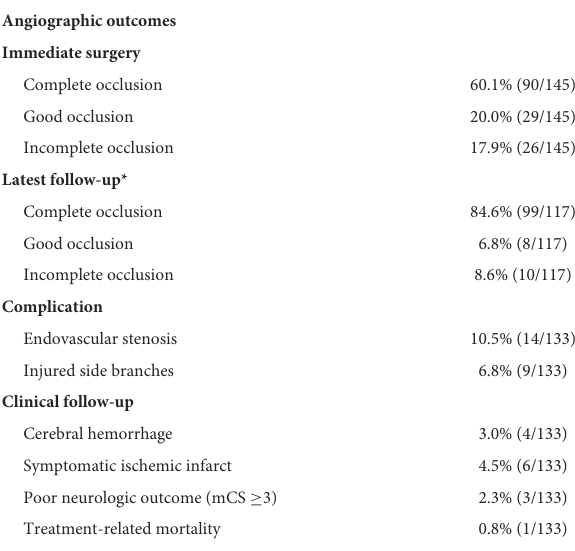
TABLE 2 The outcomes of treatment.